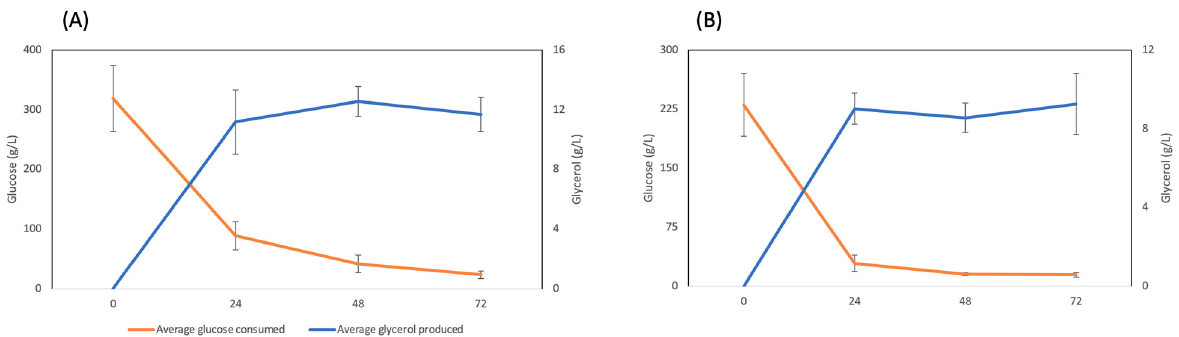
Figure 6. Average fermentation product yields for ethanol ( A ), isopropanol ( B ), acetic acid ( C ), succinic acid ( D ), ⍺ -glyc- erylphosphorylcholine ( E ), and glycerol ( F ) for barley with and without hulls. 3.2. Concentration of Organic Solutes in Oat Cultivars Compared to the average product accumulation observed in the fermented barley mash, oat mash accumulated less ethanol, isopropanol, acetic acid, α -GPC, and glycerol